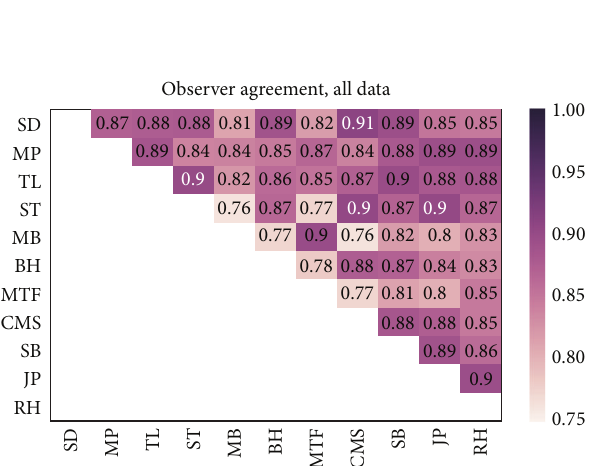
,betweenobserversacrossall 𝑁 = 617 Agr